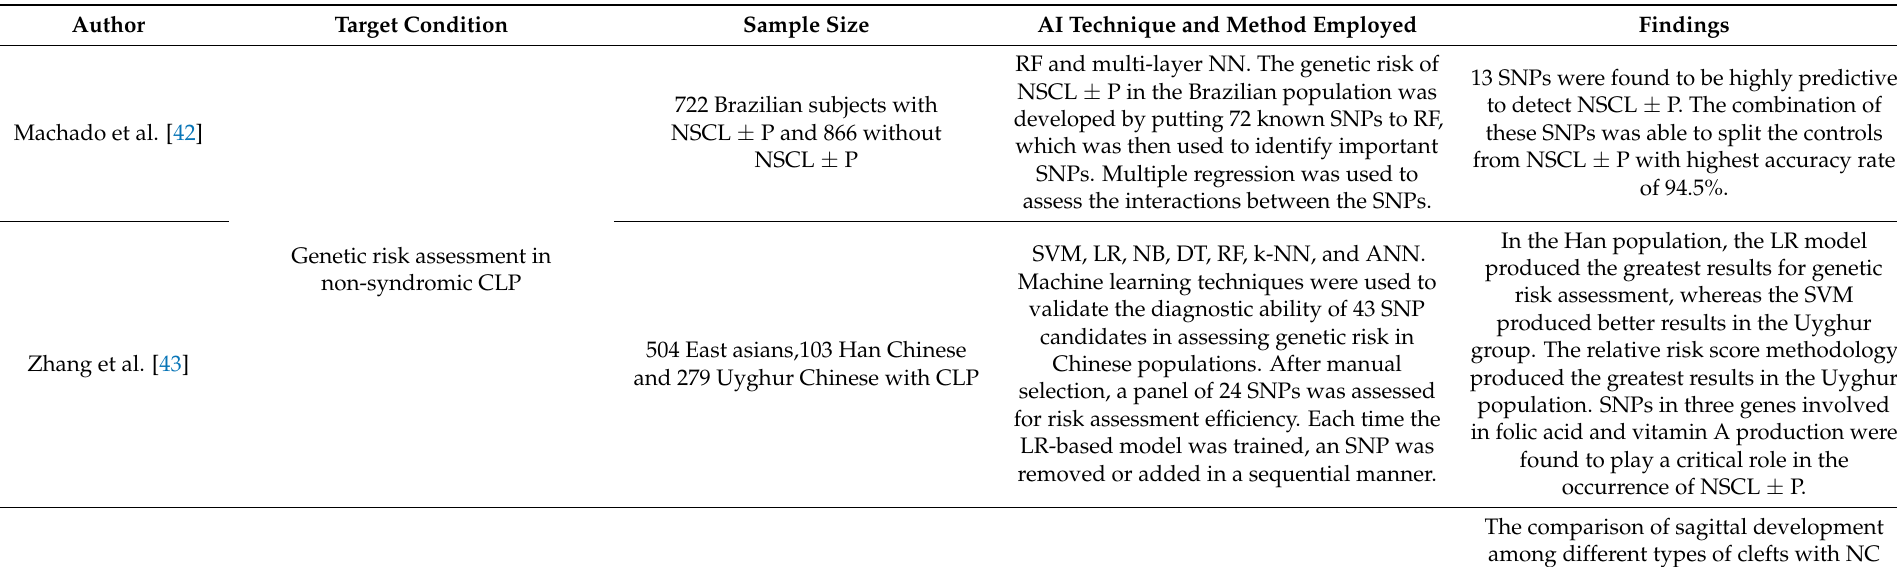
Table 4. Characteristics and Methodology of the included